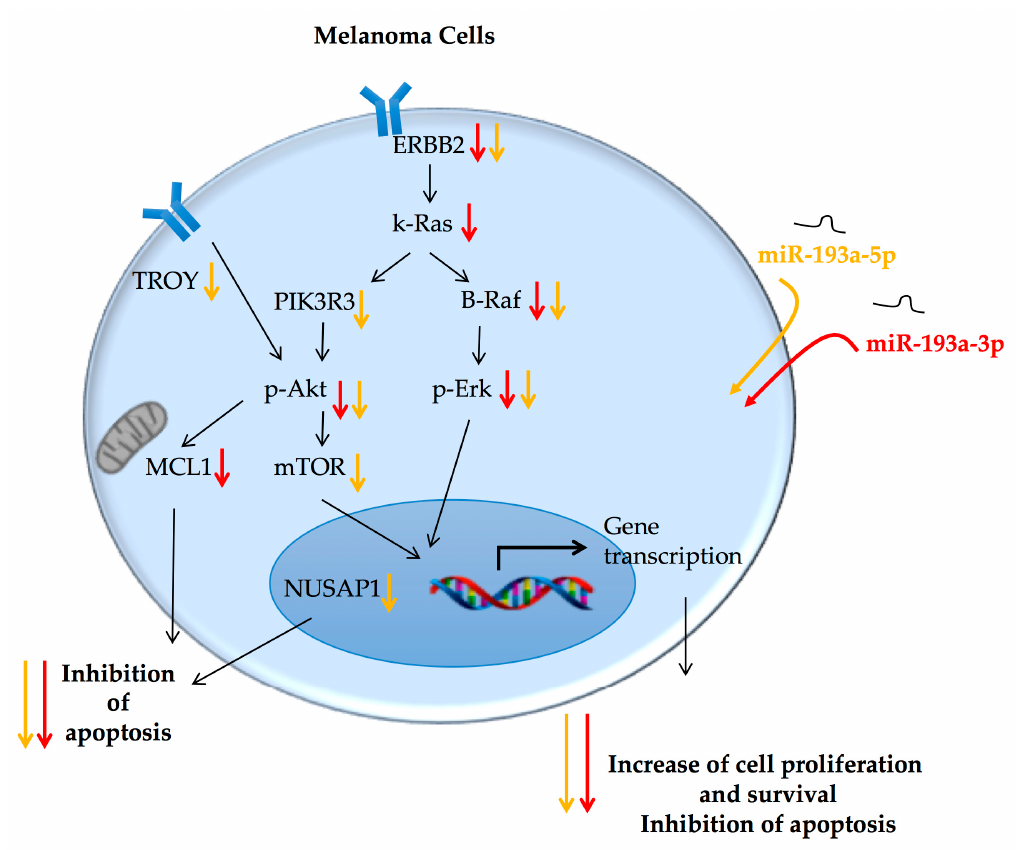
Figure 7. Schematic summary of the pathways involved in the tumor suppressor activity of miR-193a-3p and -5p in melanoma cells. Ectopic over-expression of miR-193a arms decrease melanoma cell proliferation and survival, and increases apoptosis, showing an interesting role of tumor suppressor. See the text for further details. The black arrows indicate progression; the orange arrows indicate a decrease of gene or protein expression after treatment with miR-193a-5p and the red arrows indicate a decrease of the gene or protein expression after treatment with miR-193a-3p.